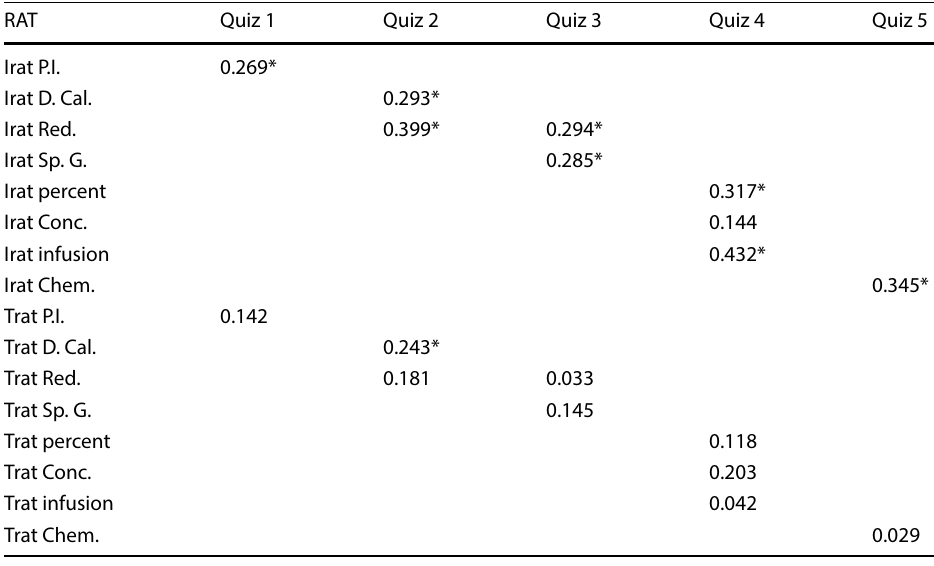
Table 1 Correlation of IRAT and TRAT scores with Quiz scores in Cohort